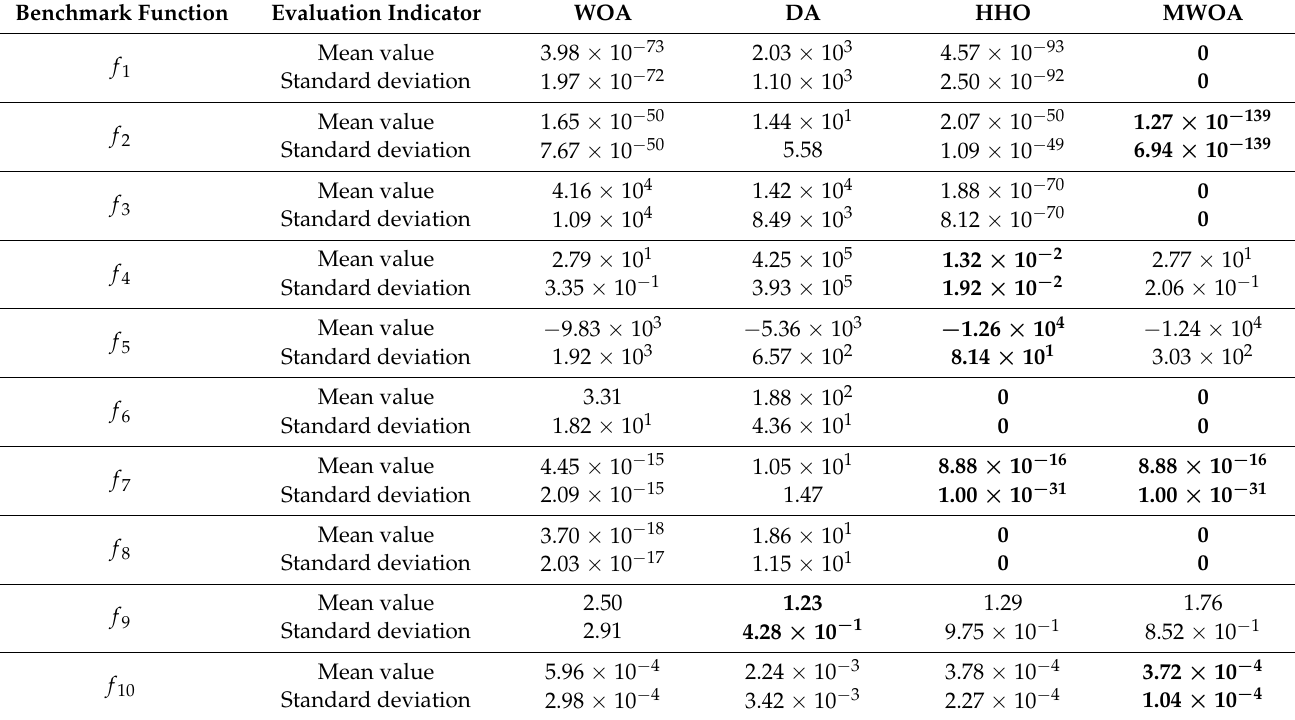
Table 4. Performance comparison of MWOA with other intelligent optimization algorithms. Benchmark Function Evaluation